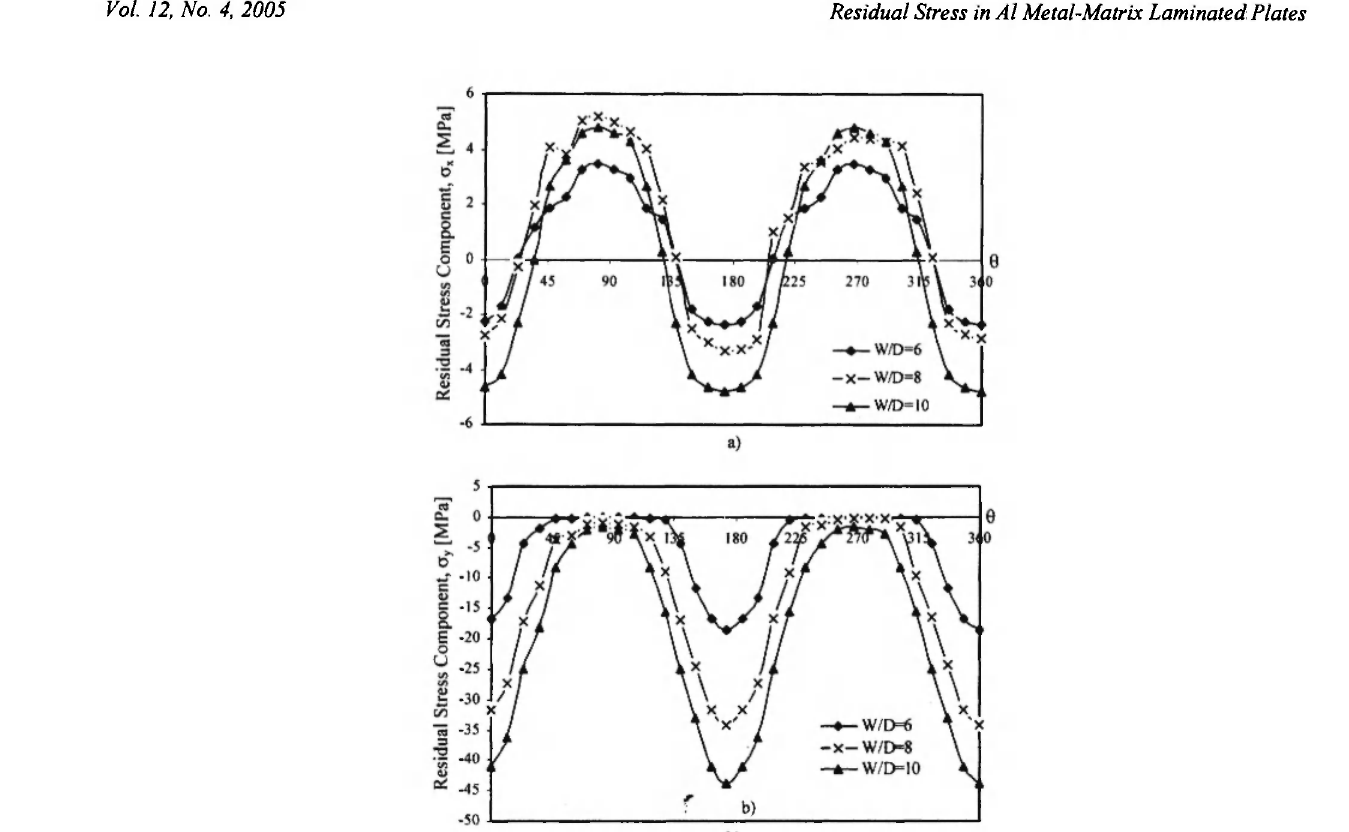
Fig. 6: Residual stress components at the border of the hole for cross-ply [0°/90°] s , laminated plates a) σ χ , b) o y